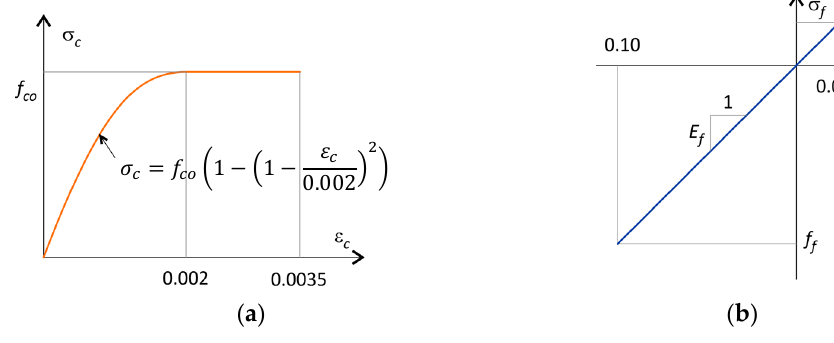
Figure 2. Material models for ( a ) concrete and ( b ) FRP bars.